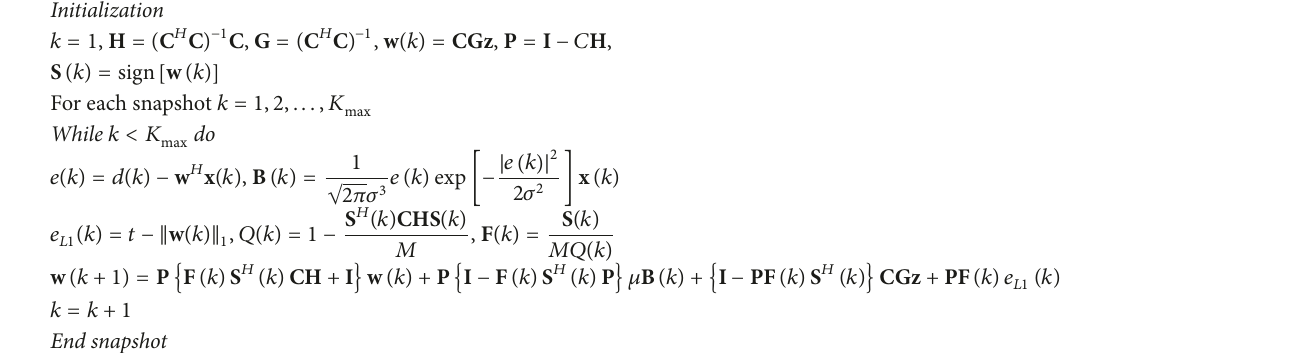
Table 1: Summary of the proposed CSMC